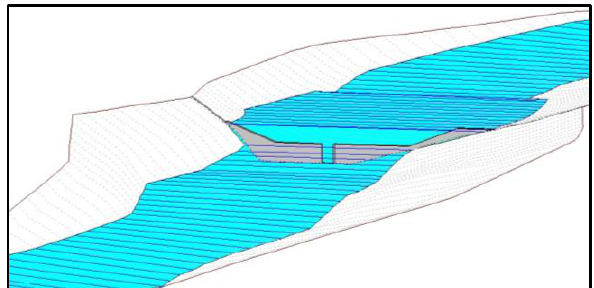
Figure 13. Three-dimensional view of River Soliette near the third slit check